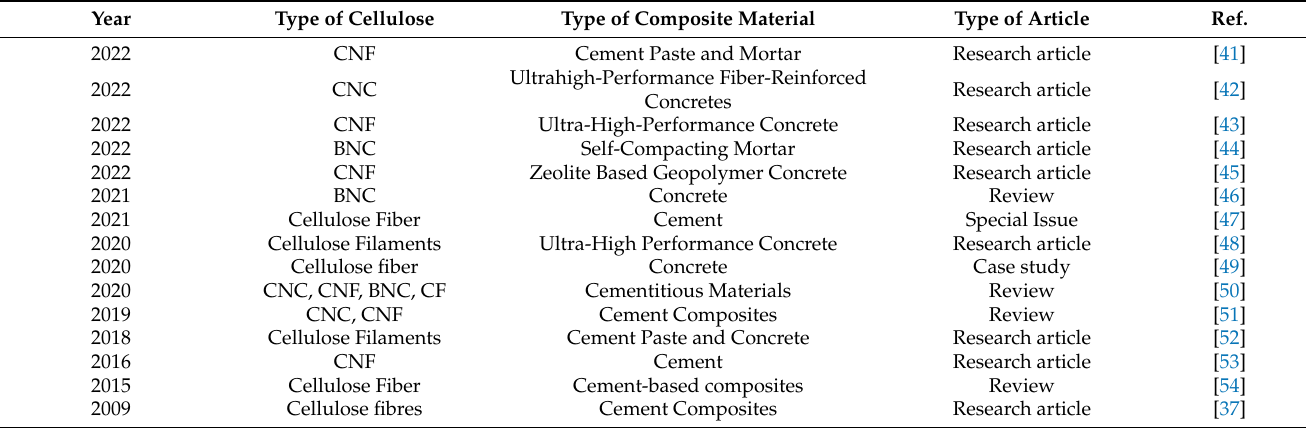
Table 1. Recently published reviews, research article, and special issues concerning cellulose as a reinforcing matrix material for polymer or fiber-cement